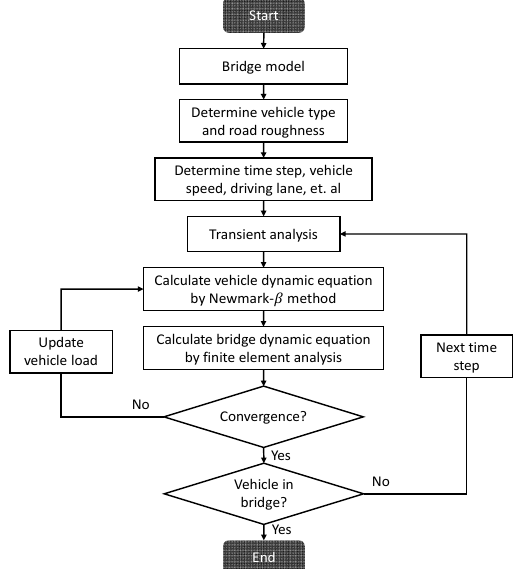
Figure 3. Flow chart of VBI program.